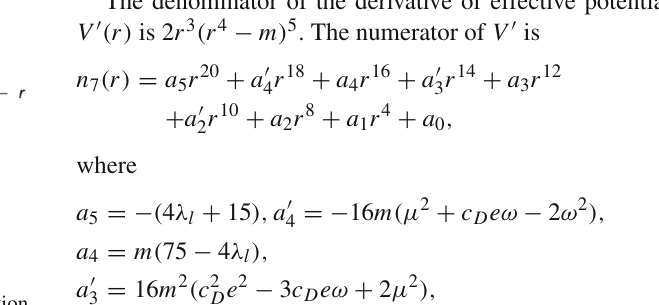
Fig. 1 Given the superradiance condition and bound state condition, a typical shape of the effective potential V ( r ) outside the black hole horizon r